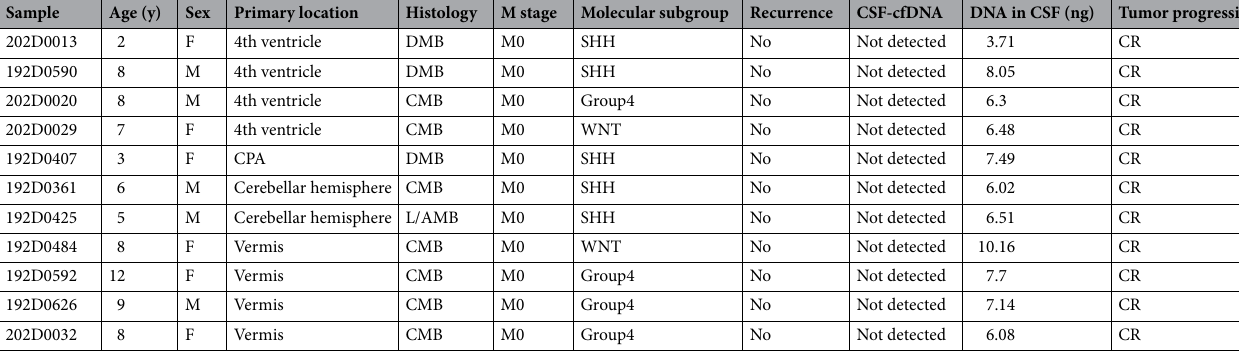
Table 1. Clinical characteristics of 58 patients with medulloblastoma. CR, complete remission; PD, progressive disease; SD, stable disease; PR, partial remission; CPA, cerebellopontine angle.